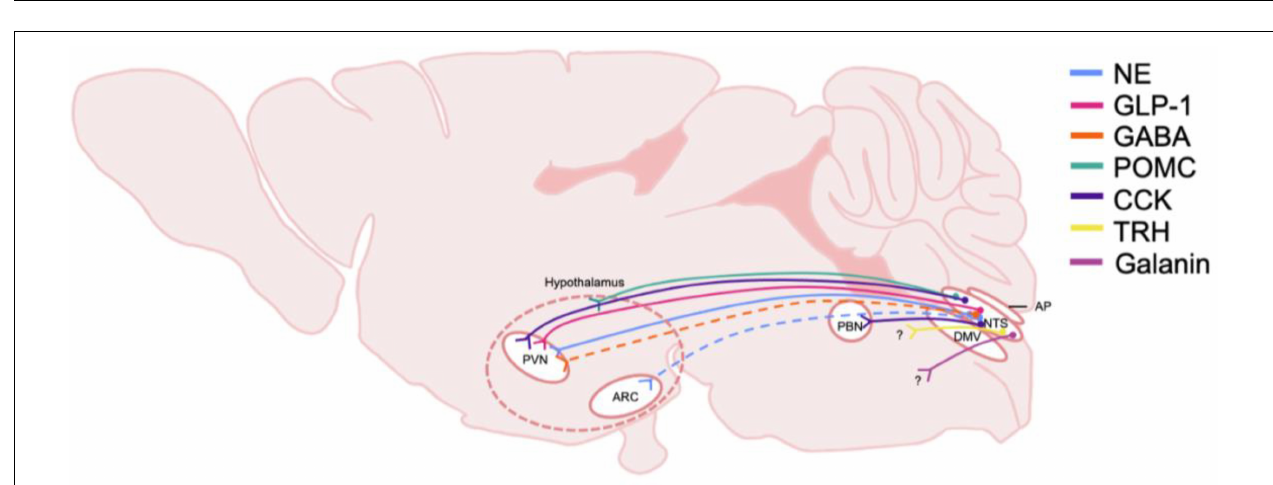
FIGURE 2 | Schematic of DVC projections hypothesized to be involved in central homeostatic systems and AUD. The origin and distribution of central neurotransmitter and peptide pathways participating in consumption behaviors and energy homeostasis and potentially involved in AUD. Peptide and transmitter systems include NE, norepinephrine; GLP-1, glucagon-like peptide 1; GABA, gamma-aminobutyric acid; POMC, pro-opiomelanocortin; CCK, cholecystokinin; TRH, thyrotropin-releasing hormone; Galanin. These projections are derived from the NTS, nucleus of the tractus solitarius; and project to multiple nuclei in the hypothalamus including the PVN, paraventricular nucleus, and the ARC, arcuate. The general area delineating the hypothalamus is denoted with dashed lines. Note that the specific hypothalamic regions that NTS POMC neurons project to is not yet defined, thus nerve endings are shown to terminate in the general hypothalamic region. CCK neurons are shown to project to the PBN, parabrachial nucleus, which also projects heavily to the hypothalamus. Dashed lines indicate that projections have been identified, but functionality and relevance to AUD is not known. Question marks indicate that immunohistochemically, neurotransmitters or peptide are present however, the termination of the projections have not been identified. DMV, dorsal motor nucleus of the vagus nerve; AP, area